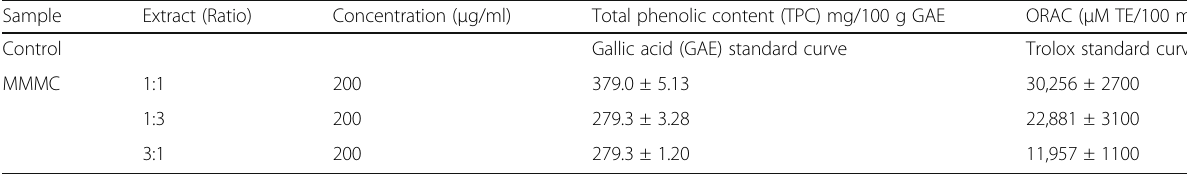
Table 1 Total phenolic content and Oxygen radical absorbance capacity of MMMC